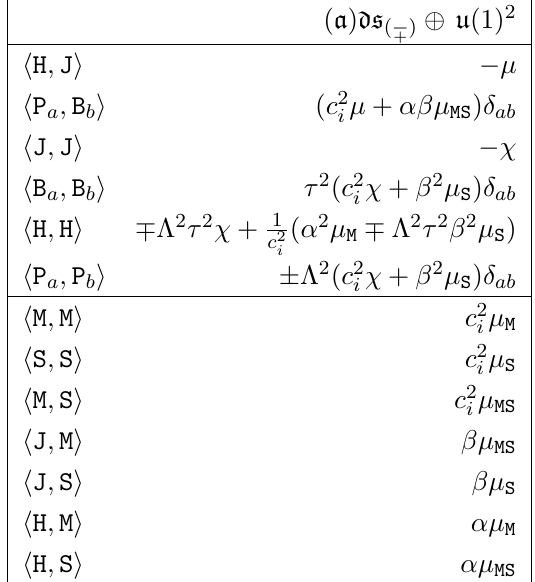
Table 2 . Rescaled and trivially centrally extended ( a ) ds algebra (left) and invariant metric (right). For a well-de(cid:12)ned nonrelativistic limit of the invariant metric we demand that (cid:11) = (cid:12) and (cid:22) (cid:6) (cid:3) 2 (cid:28) 2 (cid:22) . Under these conditions the limits to all theories are well-de(cid:12)ned and lead to the outer S cube of the tesseract of (cid:12)gure 1. The upper sign represents AdS, the lower dS. Let us discuss the limits